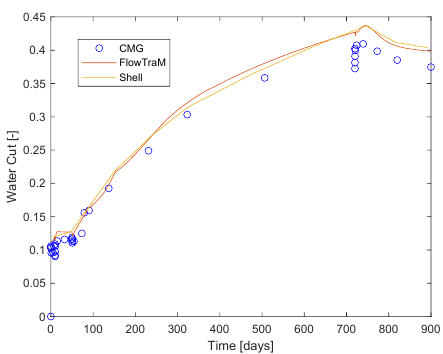
Figure 14. Comparison of water cut.